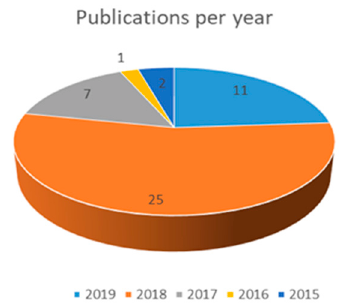
Figure 3. Year of publications included in this study (own elaboration).